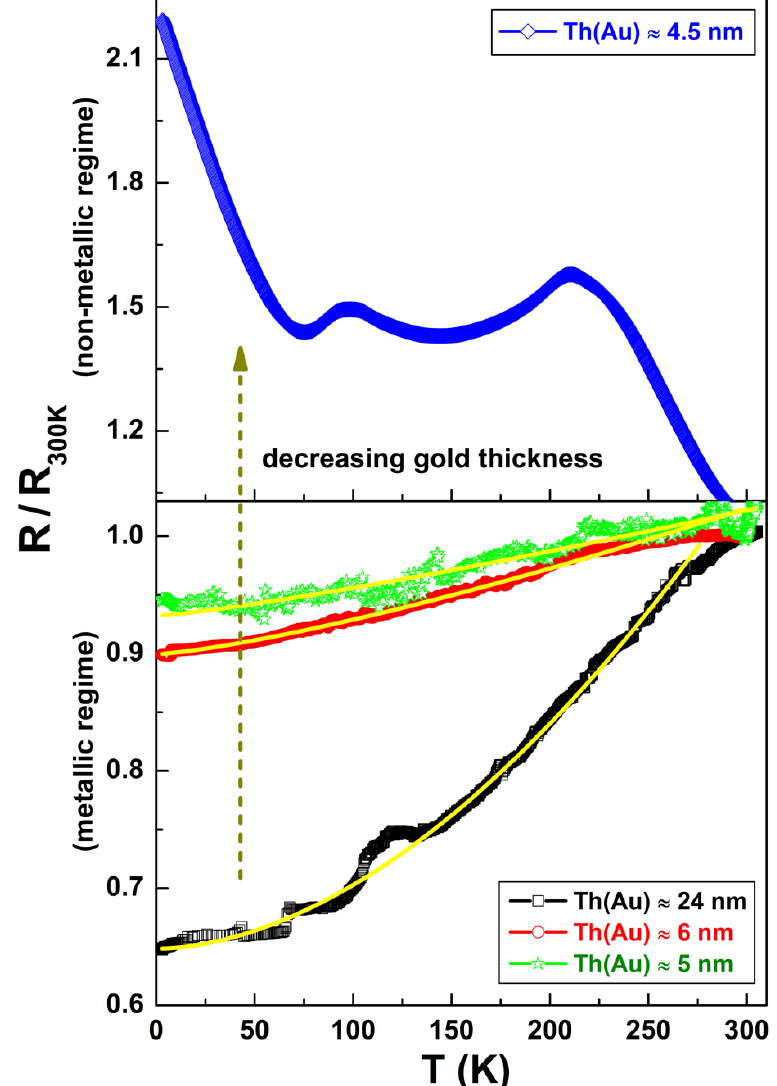
Figure 2. Temperature dependence of the ratio R / R 300 K , where R 300 K is the room temperature resistance value. From an Au layer of 24 nm (black squares) down to 6 nm (red circles) and 5 nm (green stars), the behavior became increasingly less metallic (lower panel). A change in the electrical transport mechanism is clearly visible for the thinnest Au film (blue diamonds), characterized by a strong non-metallic behavior (upper panel).